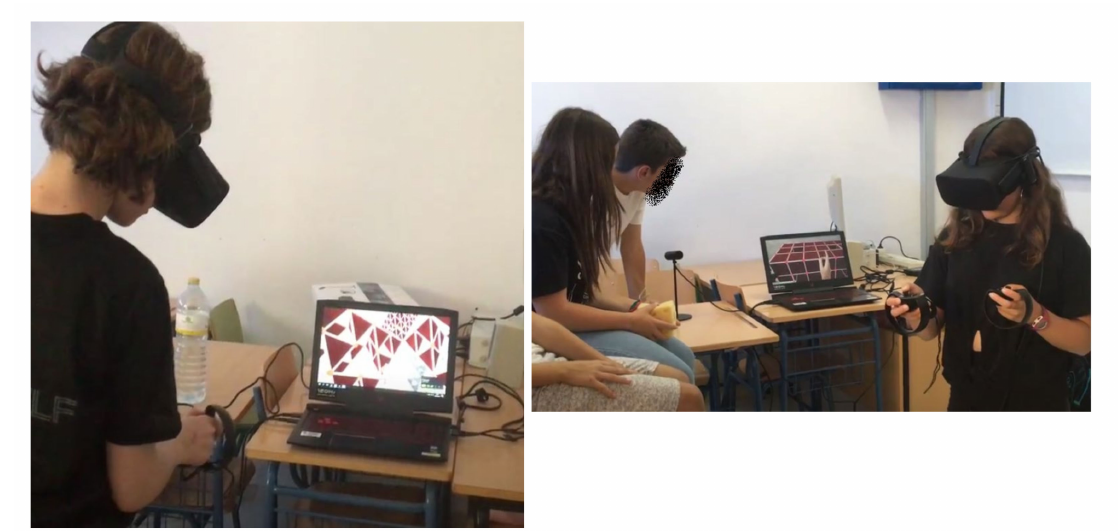
Figure 15. Pasting iterations. Help with a physical model of the second iteration of the Menger